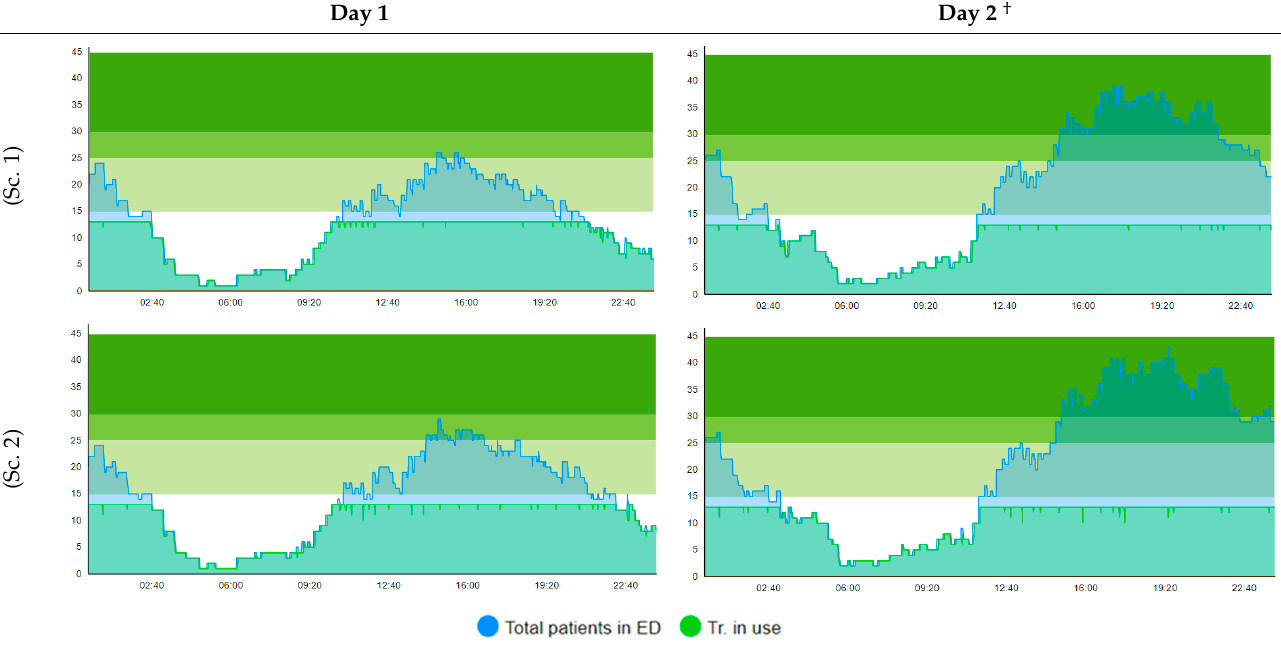
Table 9. Table displaying a subset selection of KPI from Sc.3. Key Patient Flow Indicator